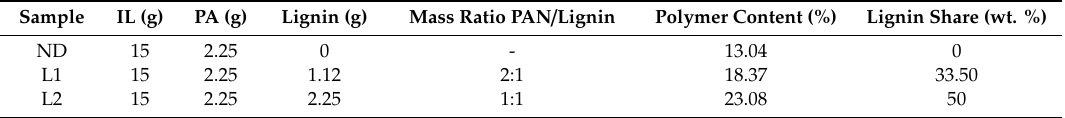
Table 1. Composition and polymer ratios of the investigated dopes in lab-scale. IL, ionic liquid; PAN,